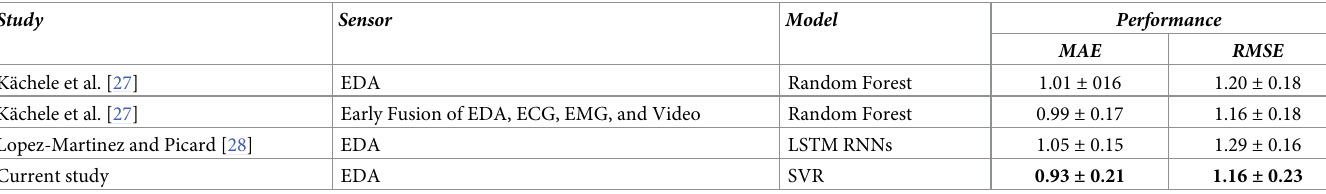
Table 4. Comparing the subject-independent pain prediction performances in the